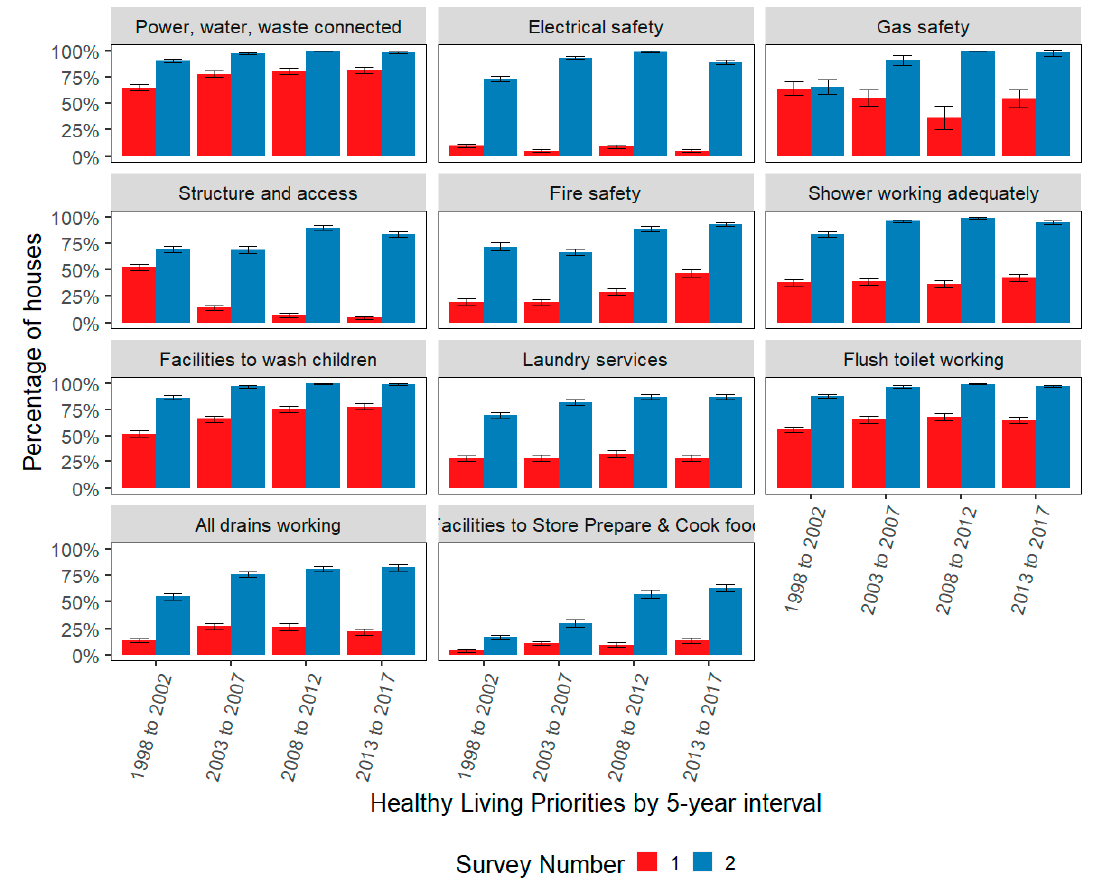
Figure A4. Percentage of houses where Critical Healthy Living Priorities were fully met at Survey-Fix1 and Survey–Fix 2 by 5-year intervals from 1998–2017.